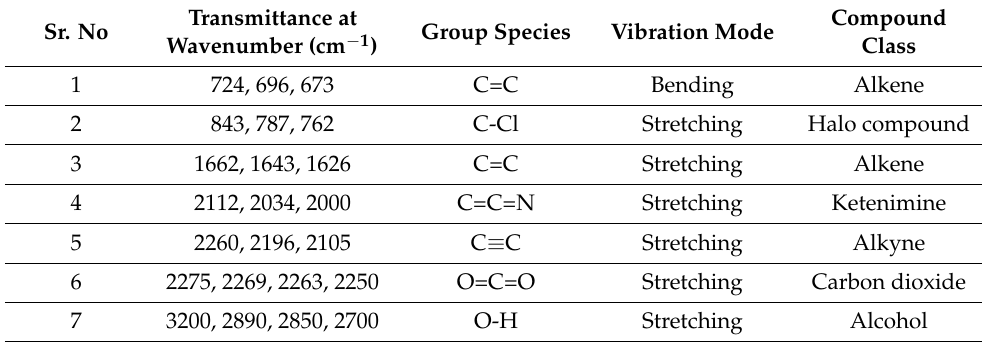
Table 1. FTIR analysis of the functional groups of degraded byproducts of DCF sodium using the Fe 2+ /PS process.